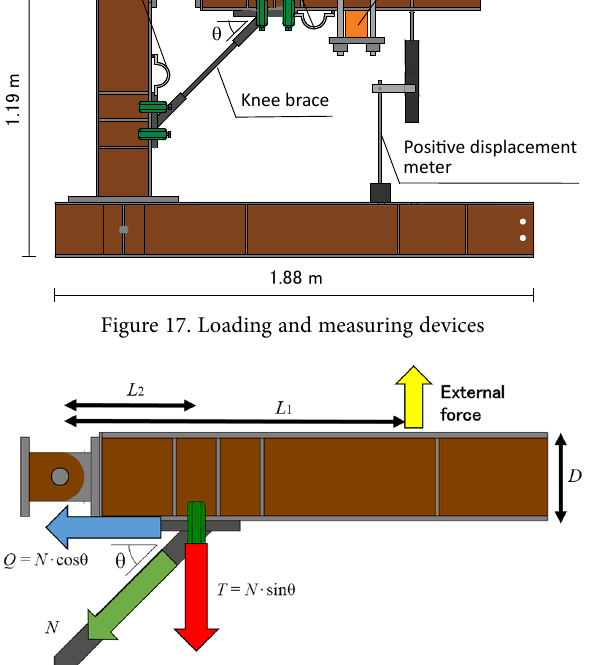
Figure 20. Relations between Q and ∆